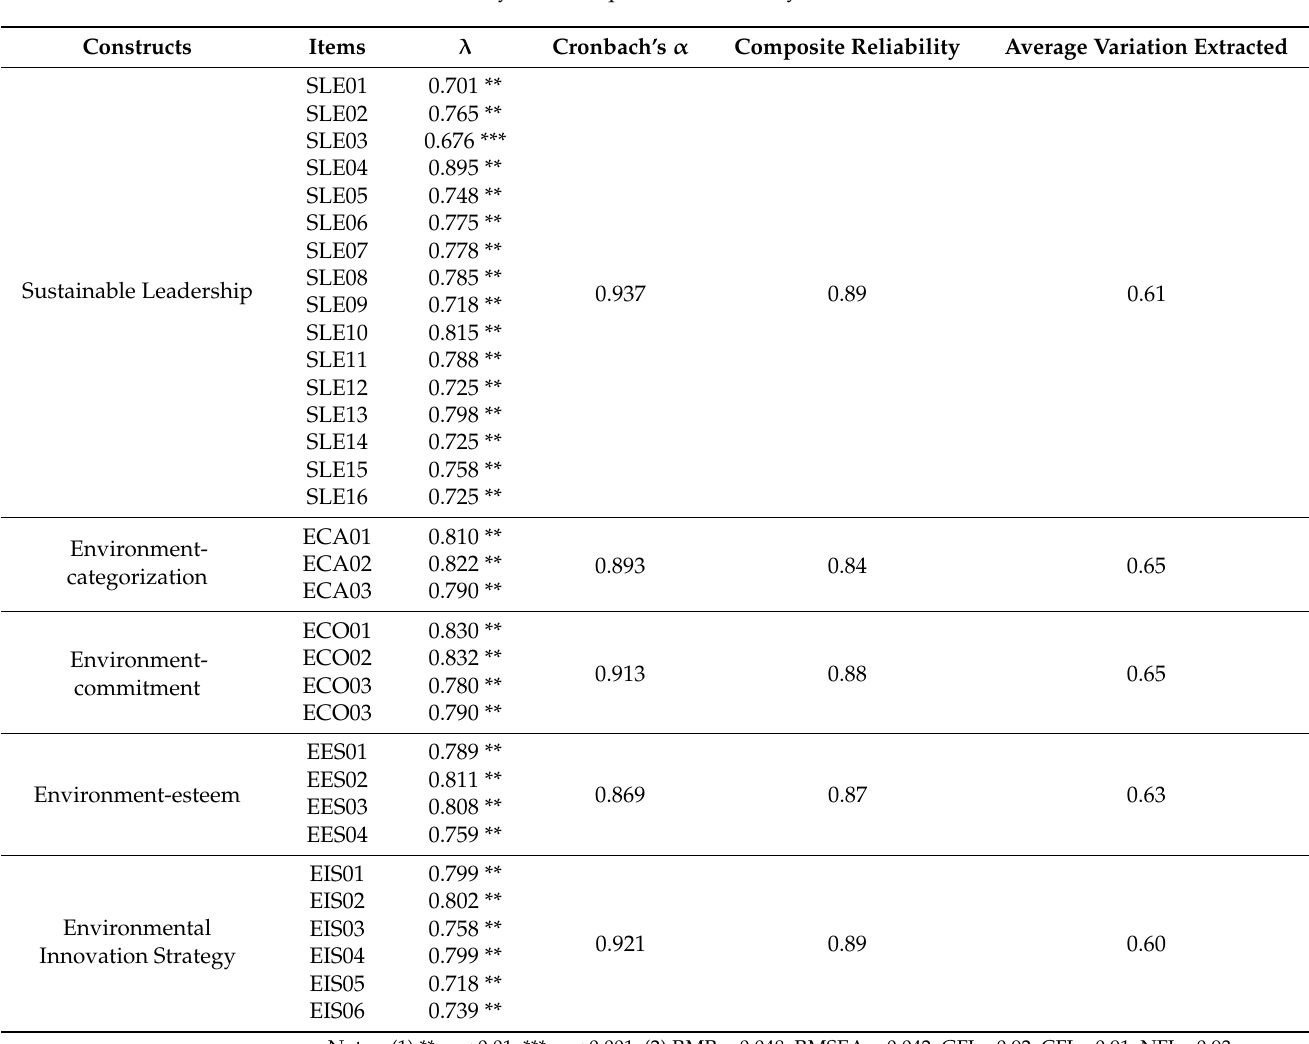
Table 2. The analysis technique of confirmatory